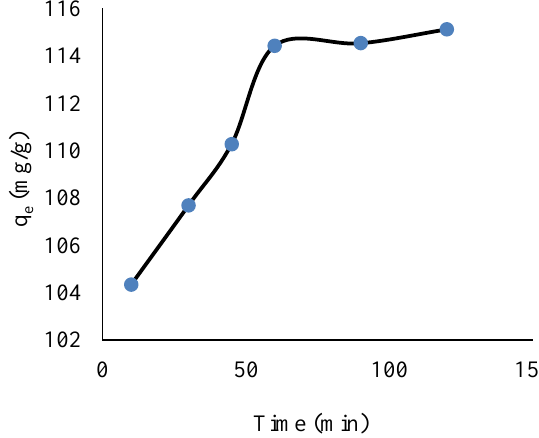
Fig. 9. Effect of contact time on removal efficiency using EDTA and chitosan-modified MWCNT (pH=7, adsorbent dose: 0.5 g/L, dye content 60